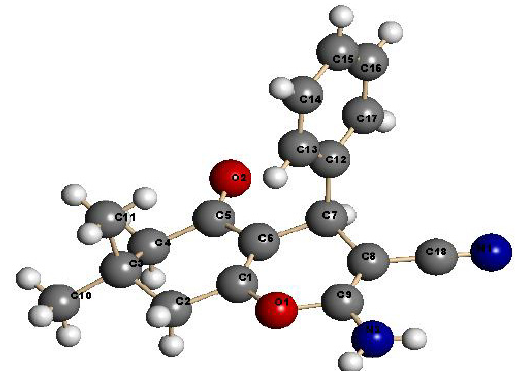
Figure 3. X-ray crystal structure of chromene-3-carbonitrile derivative 2